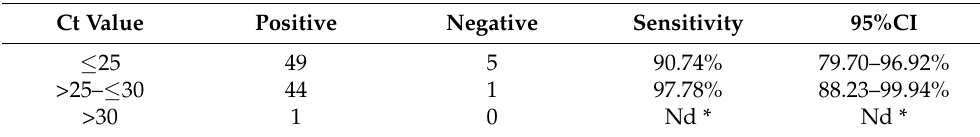
Table 5. Clinical sensitivity of the GenBody COVID-19 Ag test (COVAG025) based on Ct